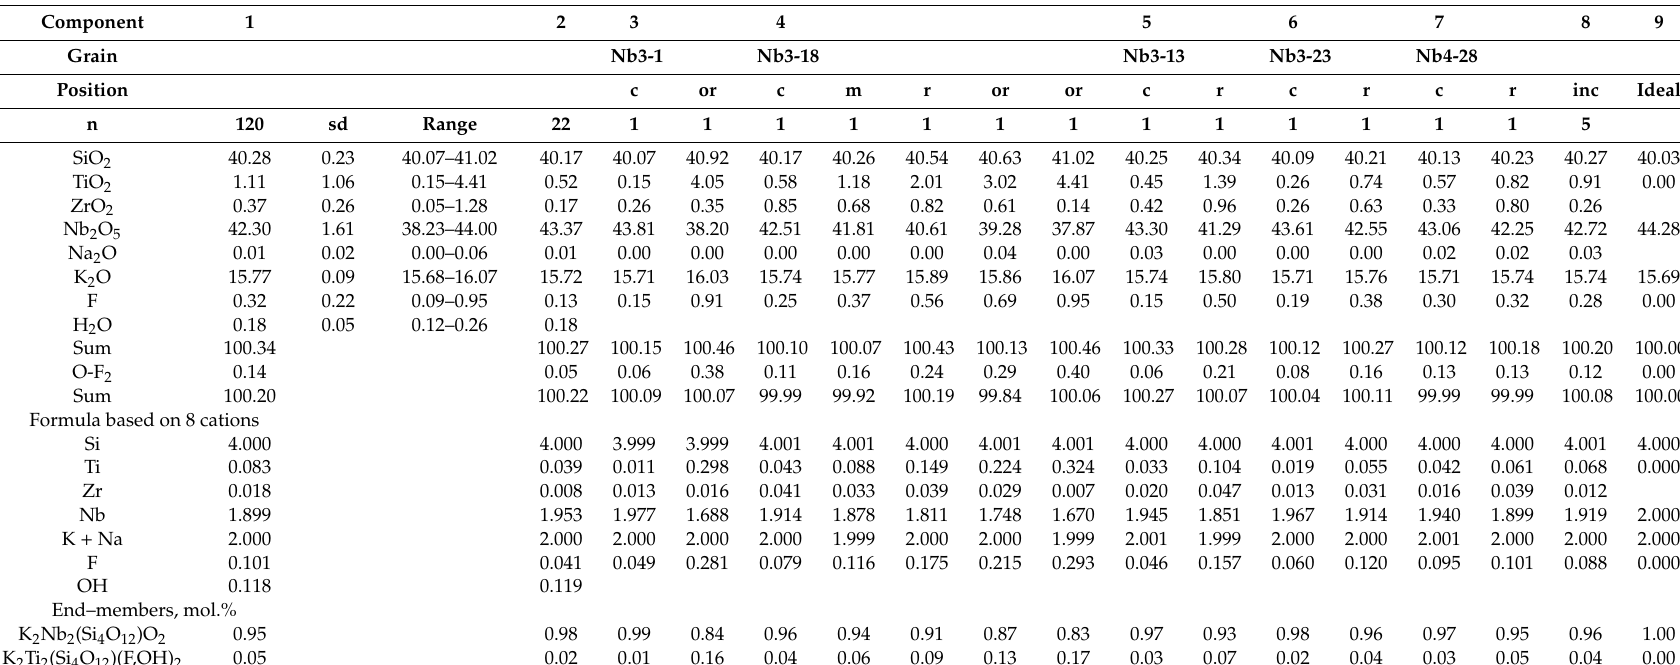
Table 2. Chemical composition (EMPA-WDS, wt %) of rippite from the Chuktukon calciocarbonatite (holotype sample 546-193.5), Chadobets upland, Siberia, Russia.